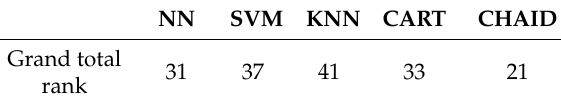
Table 5. Total performance